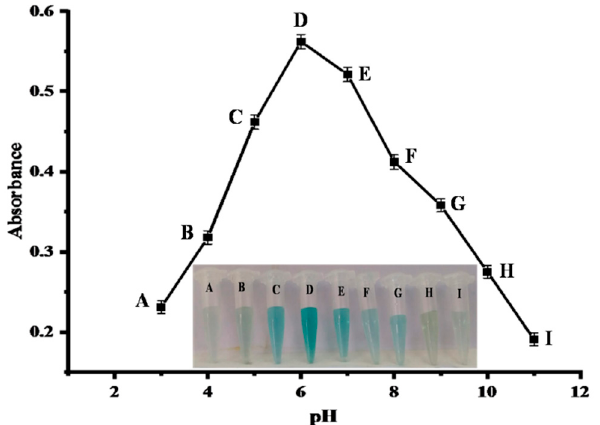
Figure 9. Optimization of pH within the range of 3–11. Reaction conditions; capped amount of Co/CeO 2 /C/IL = 50 µL, TMB = 180 µL (10 Mm), PBS = 500 µL of (pH 7.0), H 2 O 2 85 µL (6 mM). Co/CeO 2 /C/IL = 50 µ L, TMB = 180 µ L (10 Mm), PBS = 500 µ L of (pH 7.0), H 2 O 2 85 µ L (6 mM).